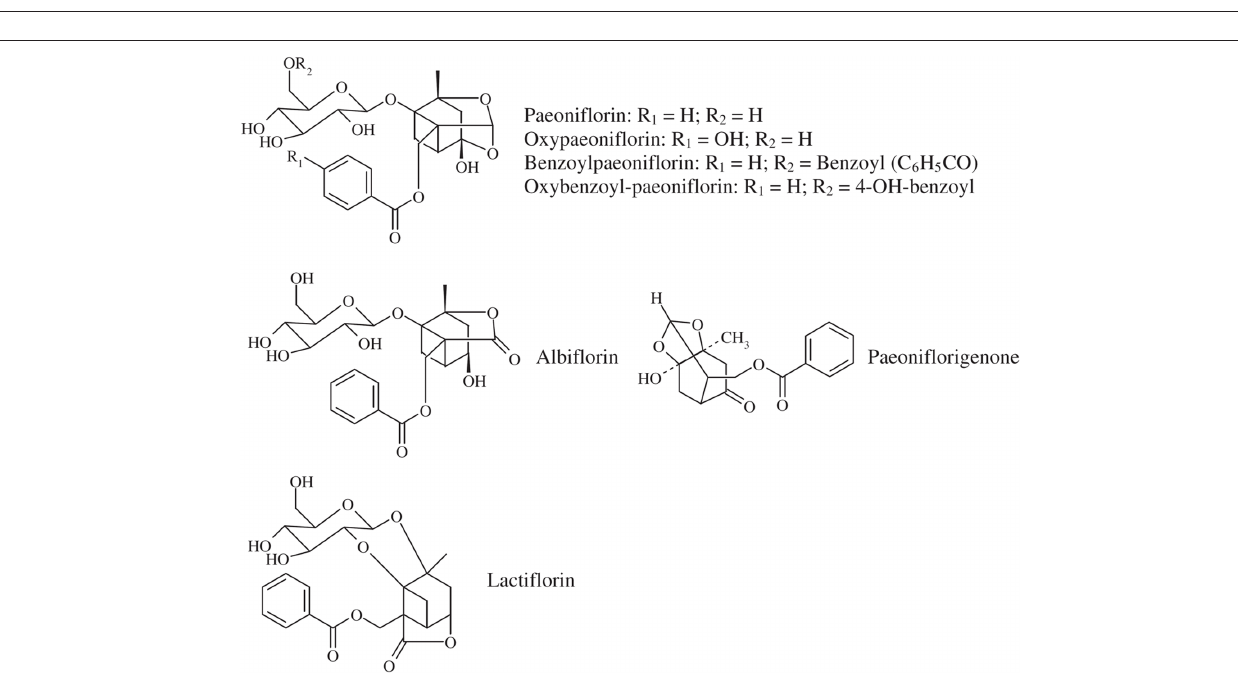
Figure 1 | Paeonia lactiflora Pall. (A) overground part of the plant; (B) root; (C) scheme of an intact plant.